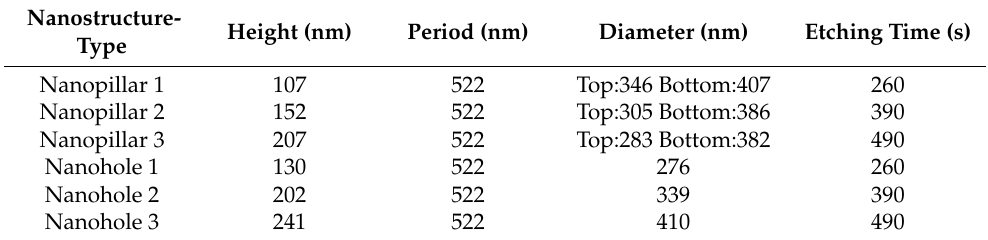
Figure 2. The SEM images for ( a ) top view of nanopillar 1 on Si substrate, ( b ) top view of nanopillar 2 on Si substrate, ( c ) top view of nanopillar 3 on Si substrate, ( d ) top view of nanohole 1 on Si substrate, ( e ) top view of nanohole 2 on Si substrate, ( f ) top view of nanohole 3 on Si substrate (The side view SEM images of each nanostructure as shown in its own inset). Table 1. Size parameters and etching time of nanopillars and nanoholes.